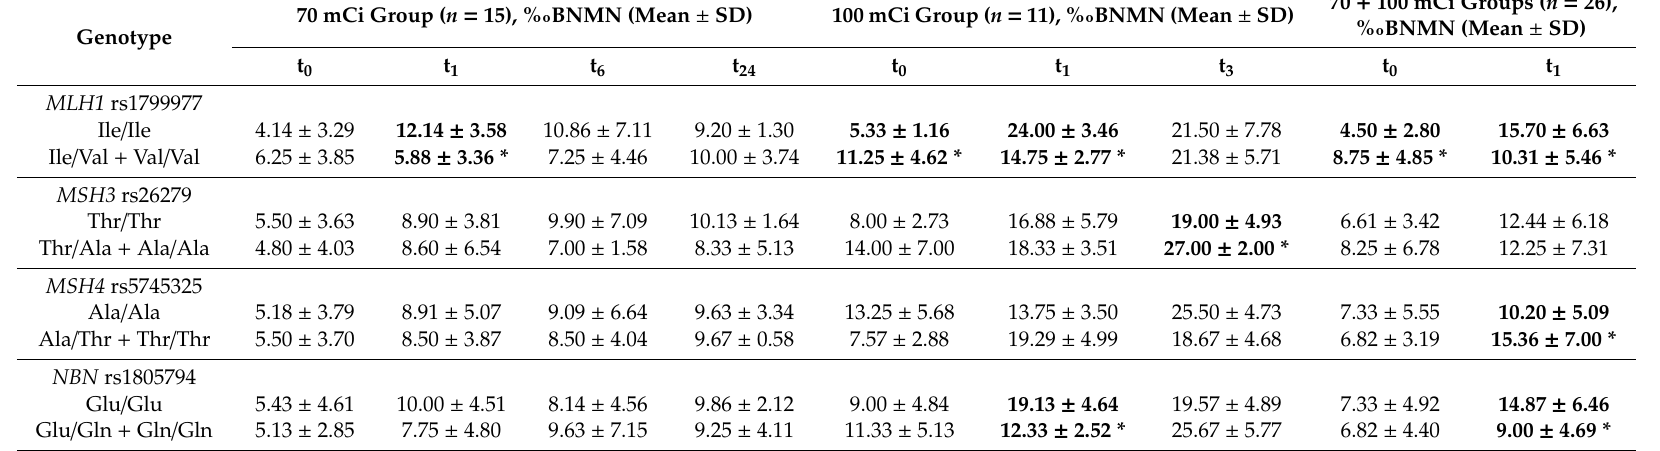
Table 4. Frequency of micronucleated cells (% (cid:24) BNMN, mean ± SD) in each 131 I dose group at t 0 , t 1 , t 3 / t 6, and t 24 , according to genotype (only SNPs presenting significant findings are shown).